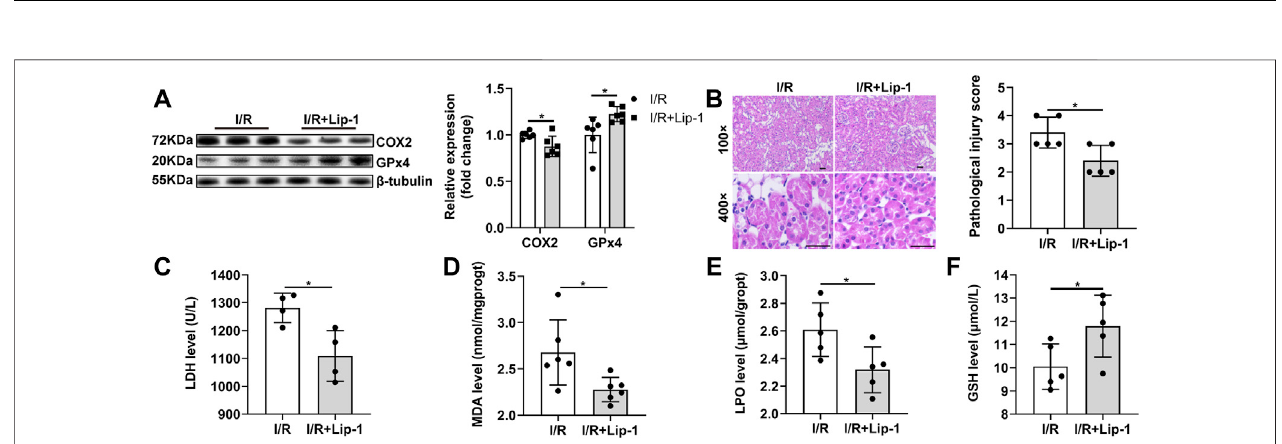
FIGURE 3 | Liproxstatin-1(Lip-1) ameliorates renal I/R injury by inhibiting ferroptosis. (A) Western blot analysis of COX2 and GPx4 in the renal tissue ( n = 6). (B) RepresentativeH&Estaining(originalmagni fi cation,×100or×400,scalebar=20 μ m)andcorrespondingrenalinjuryscore(n=5). (C) SerumLDHlevel( n =4). (D) MDA levels in renal homogenates ( n = 6). (E) LPO production in renal homogenates (n = 5). (F) GSH levels in renal homogenates ( n = 5). The data are the Means ± S. (D) , * p < 0.05.